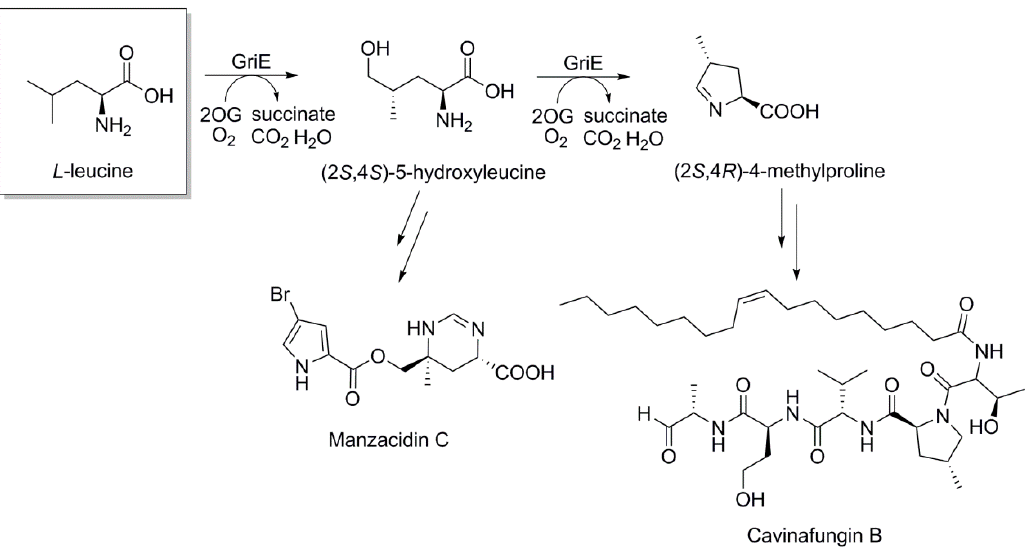
Figure 5. Total chemo-enzymatic synthesis of manzacidin C and cavinafungin B. The key building blocks (2 S , 4 S )-5-hydroxyleucine and (2 S , 4 R )-4-methylproline were prepared enzymatically using the 2-oxoglutarate-dependent oxygenase GriE.